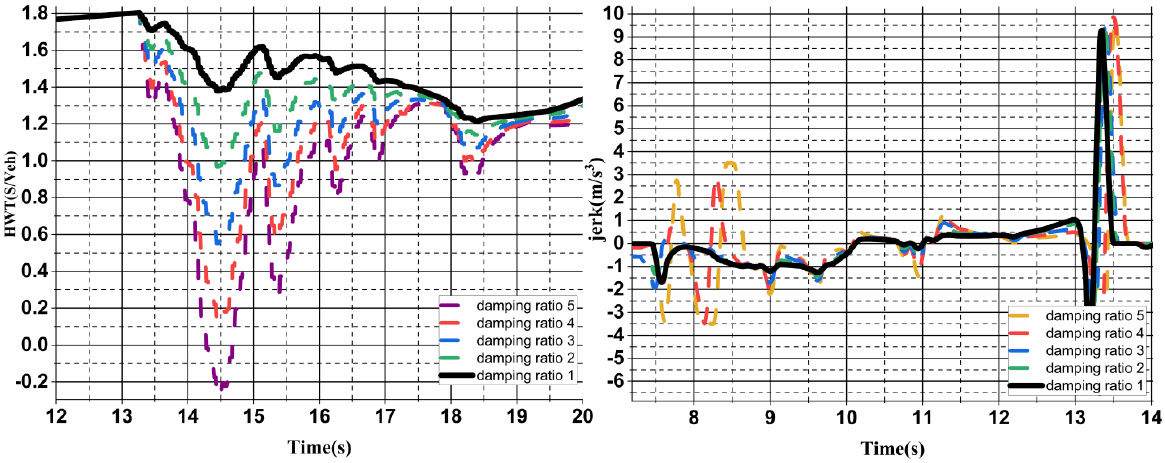
Figure 6. Working condition: team train speed of 14 km/h; cut-in vehicle speed of 12 km/h.